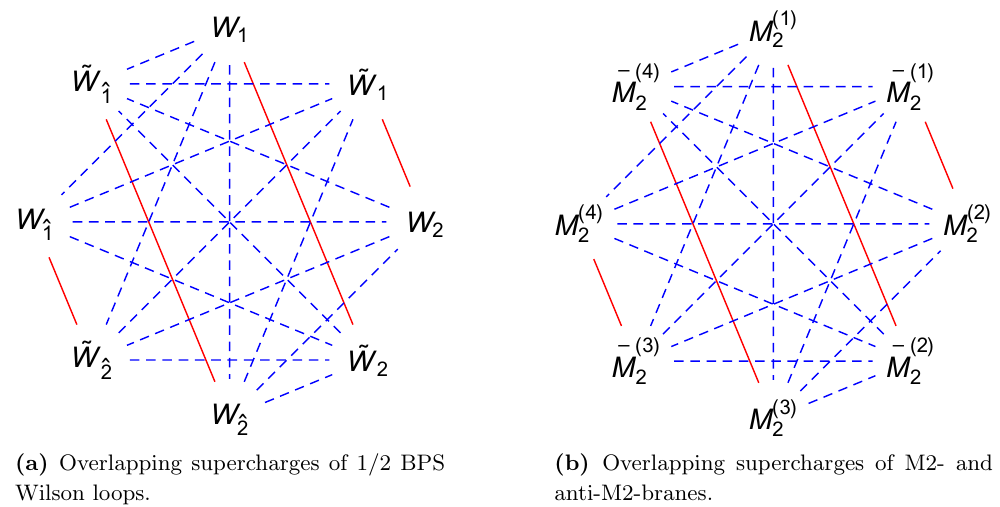
(a) Overlapping supercharges of 1/2 BPS Wilson loops. Figure 4. Amount of overlapping supercharges between each pair of 1/2 BPS WLs in N = 4 orbifold ABJM theory and between each pair of M2- and anti-M2-branes in AdS 4 (cid:2) S 7 = (Z rk (cid:2) Z r ). A red solid line means that the two WLs or branes preserve exactly the same supercharges. A blue dashed line means that the two WLs or branes share 1/2 of preserved supercharges. Two WLs or branes that are not directly connected by any line have no common preserved